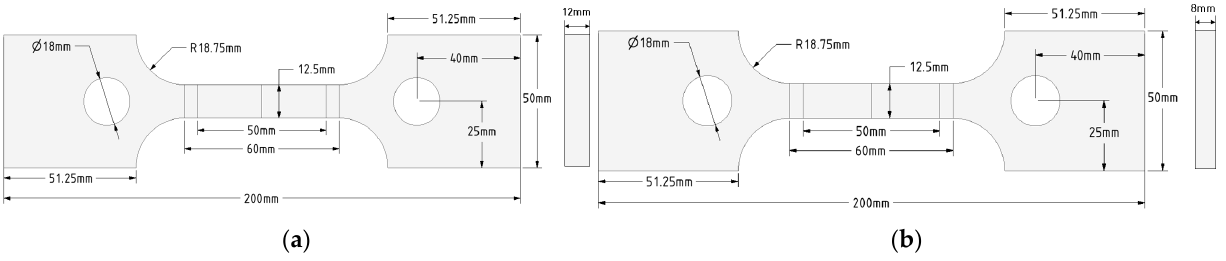
Figure 3. Detailed dimensions of tensile test specimens: ( a ) high Mn; ( b ) 9% Ni.